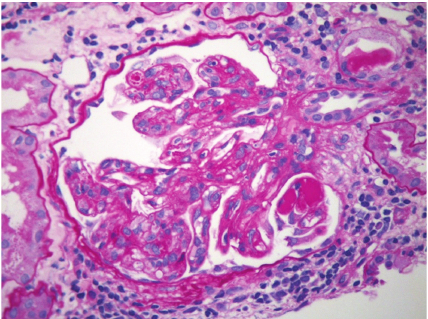
Figure 5: Membranoproliferative glomerulonephritis: subendothe- lial electron dense deposits in a patient with mixed essential cryo- globulinemia showing microtubular architecture. Microtubules measure approximately 30 nm in diameter (electron microscopy).